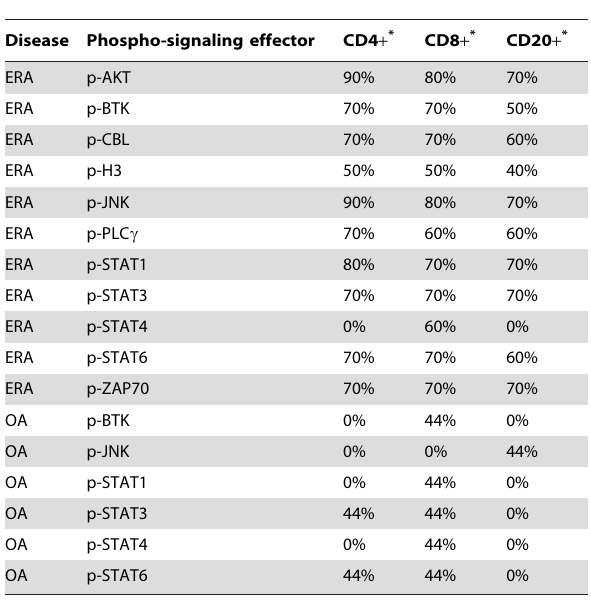
* Percentage of patients with MFI values $ 10% above the maximum level recorded in the healthy individual cohort is denoted.